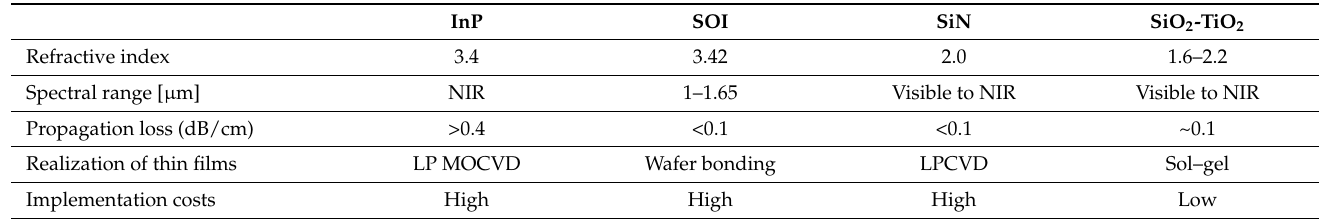
Table 1. Comparison of optical, physical, and chemical properties of InP, SOI, SiN, and SiO 2 -TiO 2